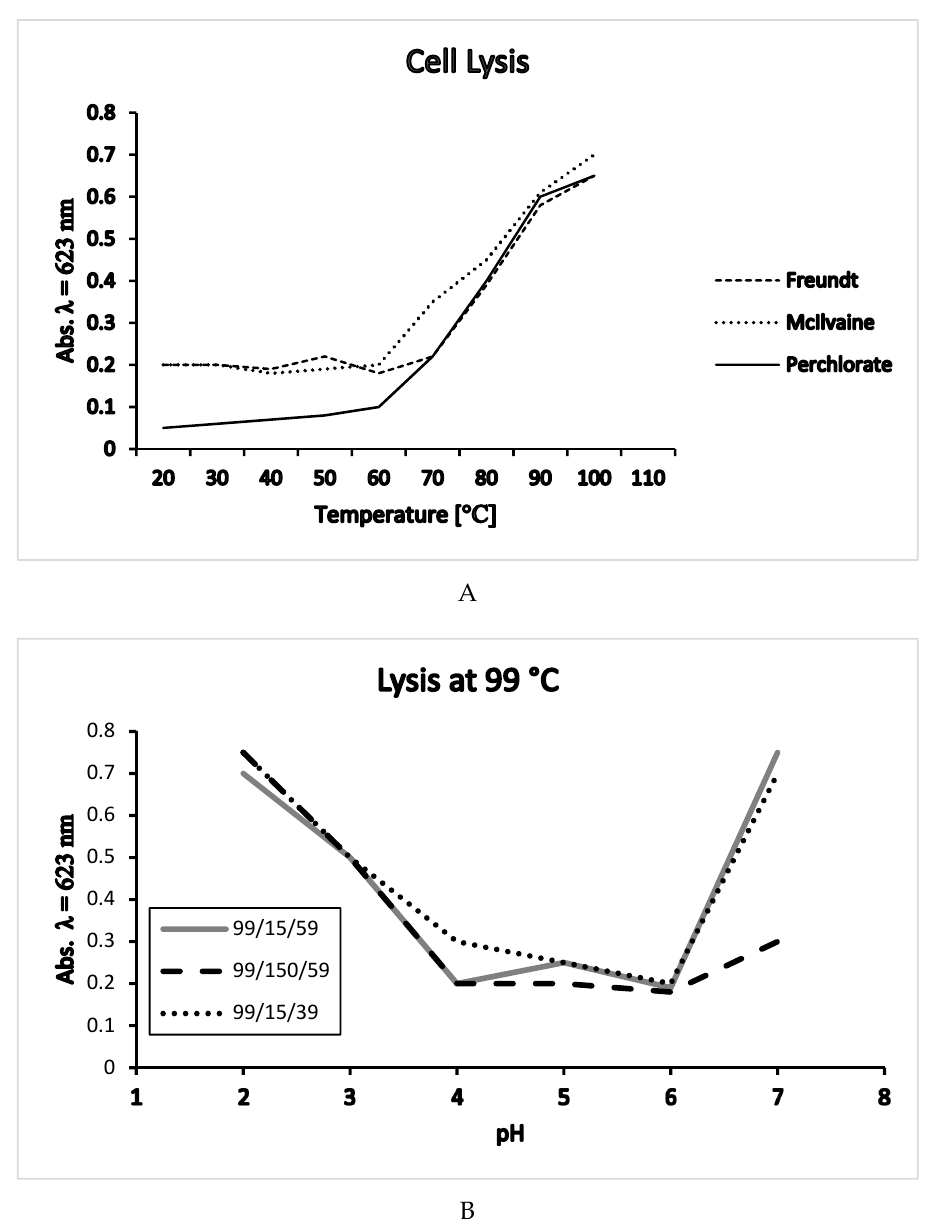
Figure 3. ( A ) Lysis experiments with Thermoplasma acidophilum cells in different buffers. ( B ) Lysis experiments with Thermoplasma acidophilum cells at 99 °C; 99/15/59; 99 = lysis temperature, 99 °C/15 = dilution with 15 mM sodium chloride solution/growth temperature of cells, 59 °C; 99/150/59; 99 = lysis temperature, 99 °C/15 = dilution with 150 mM sodium chloride solution/growth temperature of cells, 59 °C; 99/15/39; 99 = lysis temperature, 99 °C/15 = dilution with 15 mM sodium chloride solution/growth temperature of cells, 39 °C; adapted from [16].